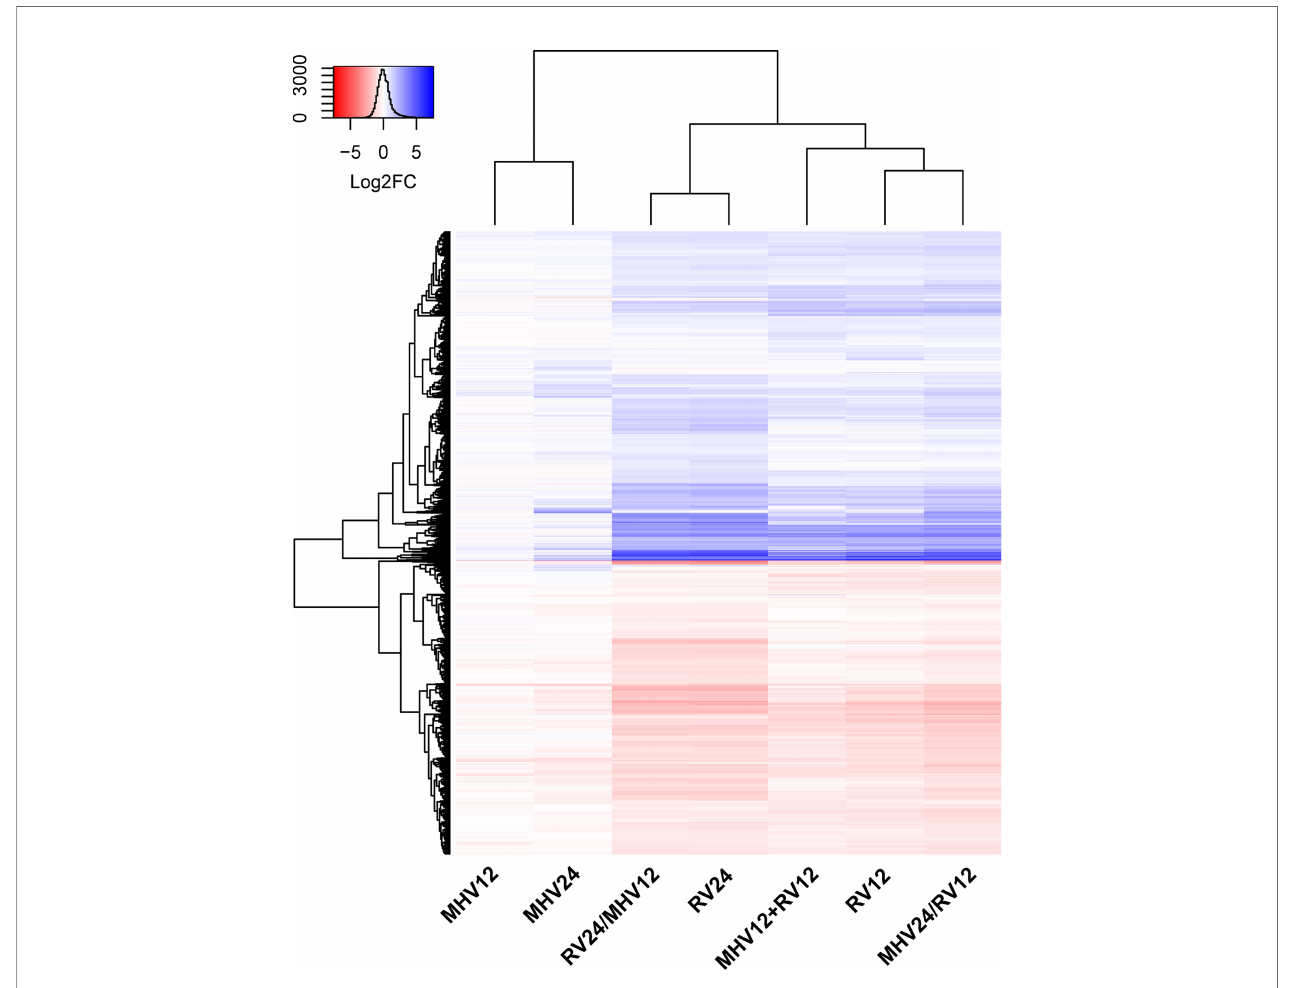
FIGURE 7 | RV dominates gene expression patterns over MHV-1 in coinfected epithelial cells. LA4 cells were inoculated with RV or MHV-1 for 12 or 24 hours (RV12, RV24, MHV12, MHV24), both viruses for 12 hours (MHV12+RV12) or one virus 12 hours before the other virus (RV24/MHV12, MHV24/RV12). RNA was isolated and host gene expression was analyzed using a mouse genome microarray. Heat map includes expression of all signi fi cantly up (blue) or down (red) regulated genes compared to mock-inoculated cells with colors indicating log 2 fold change vs. mock (see inset key). Gene and sample clustering (dendograms) were performed using hclust in R. See Supplementary Table 1 for all signi fi cant gene expression changes for each relevant pairwise